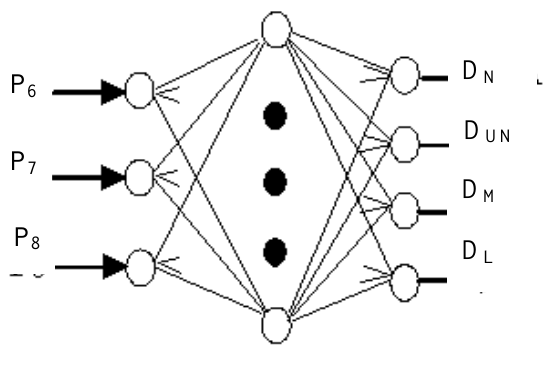
Figure 11. NN for pattern recognition in fault diagnosis.